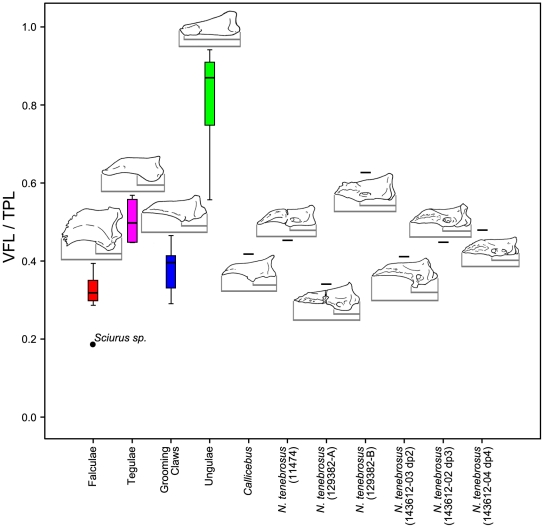
Boxplot of volar feature length scaled to total distal phalanx length.Raw values of volar feature length (VFL) are divided by total phalanx length (TPL). VFL and TPL are demonstrated using illustrations of specimens scaled to the same length and oriented according to their long axes. The median specimen from each extant group is illustrated: Galeopterus vareigatus represents the falculae group; Leontopithecus sp., tegulae; Lemur catta, grooming claws; and Galago senegalensis, ungulae. See Materials and Methods for measurement descriptions.